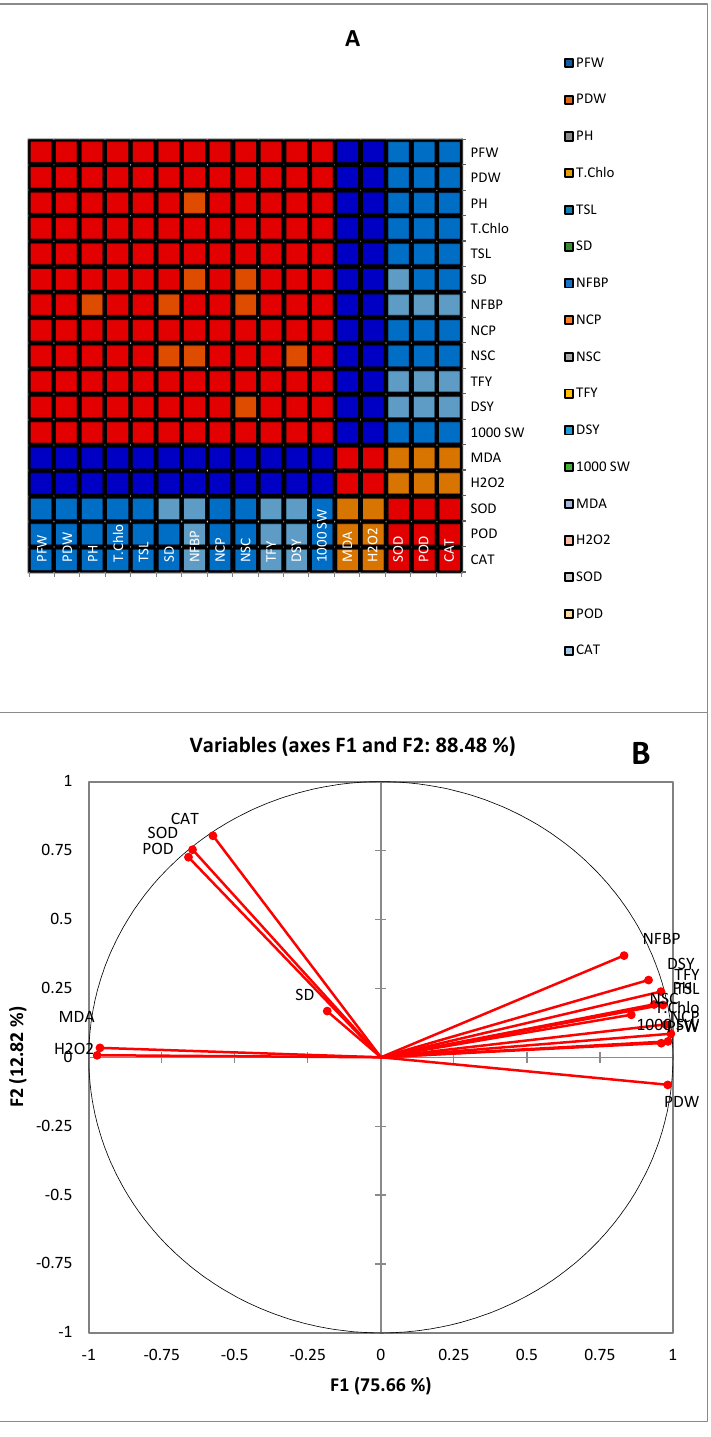
Figure 5. ( A ) Spearman correlation map of the studied variables. ( B ) PCA correlation circle. T.CHLO: total chlorophyll; TSL: technical stem length; SD: stem diameter; NFBP: number of fruit branches per plant; H 2 O 2 : hydrogen peroxide; MDA: malondialdehyde; NCP: number of capsule per plant; NSC: number of seeds per capsule; TFL: total fresh yield; DSY: dry stem yield; POD: peroxidase; CAT: catalase, 1000 seeds weight; PH: plant height; PFW: plant fresh weight; PDW: plant dry weight; SOD superoxide